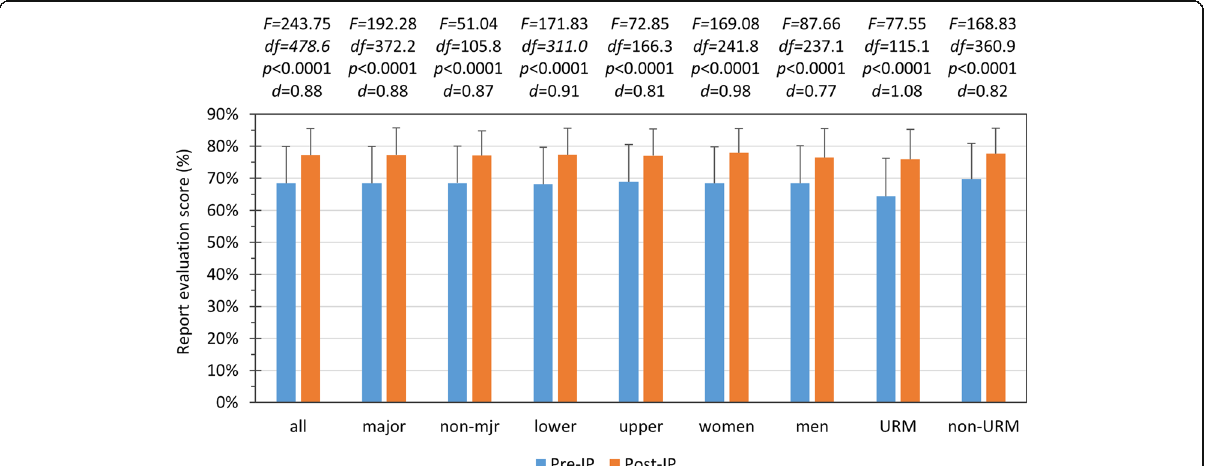
Fig. 5 Student performance in report evaluation pre- and post-inquiry project. Comparison of the pre-inquiry project (pre-IP) and post-inquiry project (post-IP) scores for evaluation of an inquiry report using a rubric, for all students ( n = 467), majors and nonmajors ( n = 336 and 101), lower- and upper-division students ( n = 301 and 166), women and men ( n = 239 and 228), and under-represented minorities (URM) and other ethnicities ( n = 116 and 352). The F ratio, df , and p value for mixed model ANOVA and the effect size (Cohen ’ s d ) are shown above each